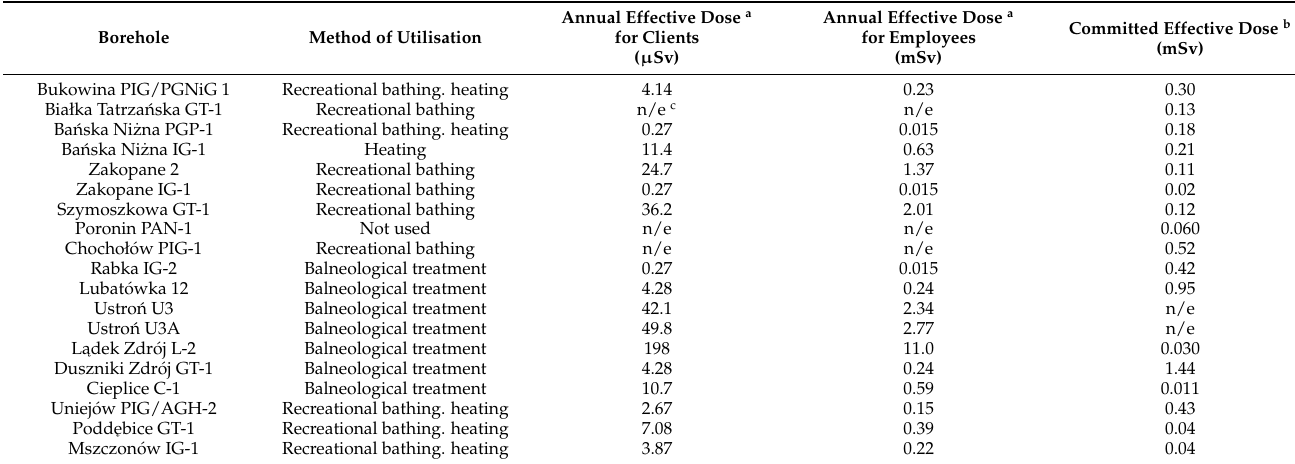
Table 3. The annual effective doses for thermal spa clients and employees and the committed effective dose resulting from